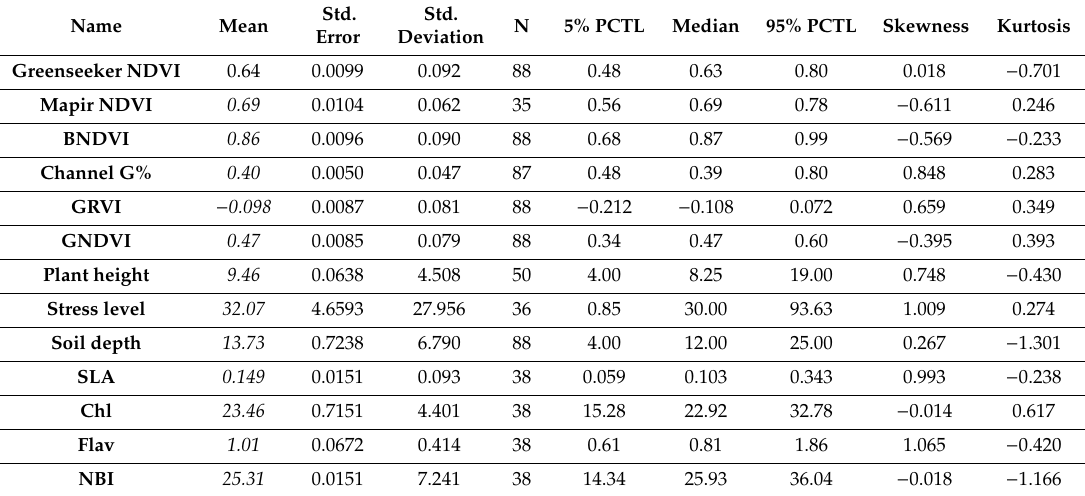
Table 3. Descriptive statistics of the monitored plant traits on plot